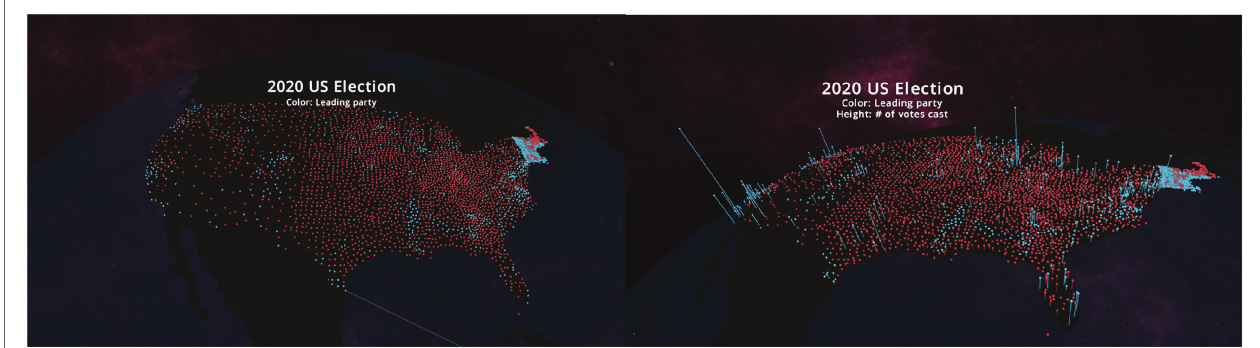
FIGURE 1 | Panel on the left is two-dimensional (2D) and makes the United States appear to have mainly voted Republican (red) in 2020; Panel on the right with a third dimension of number of people is able to highlight the difference between rural and city voting patterns, as seen by the blue spikes over cities. This Flow story was shown very soon after the November, 2020 election to spur discussion around the difference in voting patterns between rural and urban